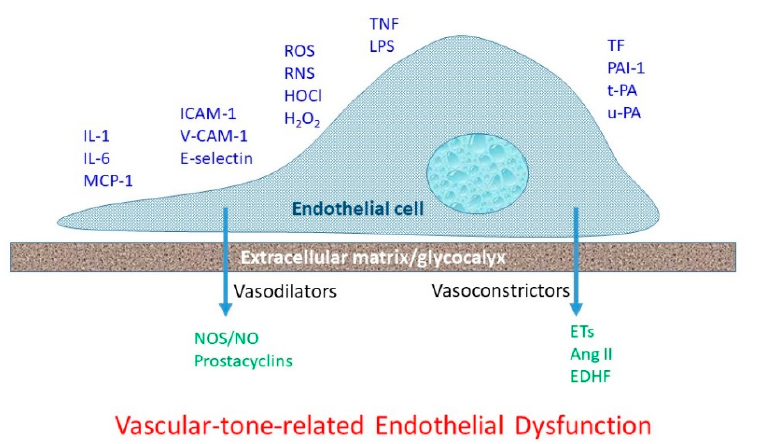
Figure 1. Mediators of endothelial dysfunction and endothelium-derived factors that influence the development and progression of atherosclerosis. Cardiovascular risk factors render the endothelium susceptible to the generation of atherosclerosis. Endothelial dysfunction affects vascular reactivity. Cytokines, inflammatory mediators, reactive oxygen species, and pro-thrombotic factors draw endothelial cells into thrombotic and immune responses. Under pathophysiological conditions, endothelial cells release hormones, cytokines and growth factors that impact vascular